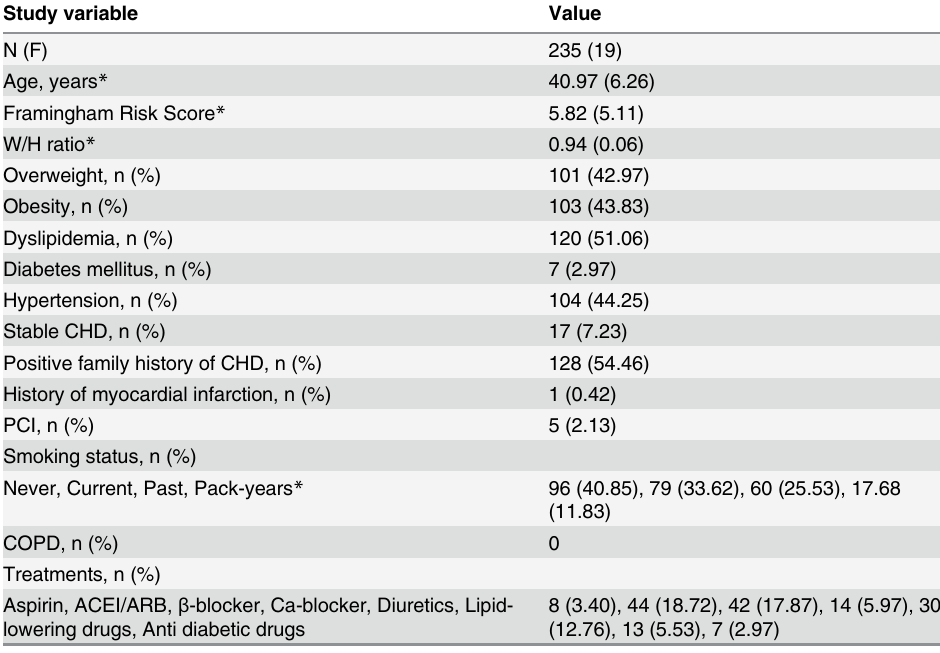
Table 1. Clinical characteristics of the study